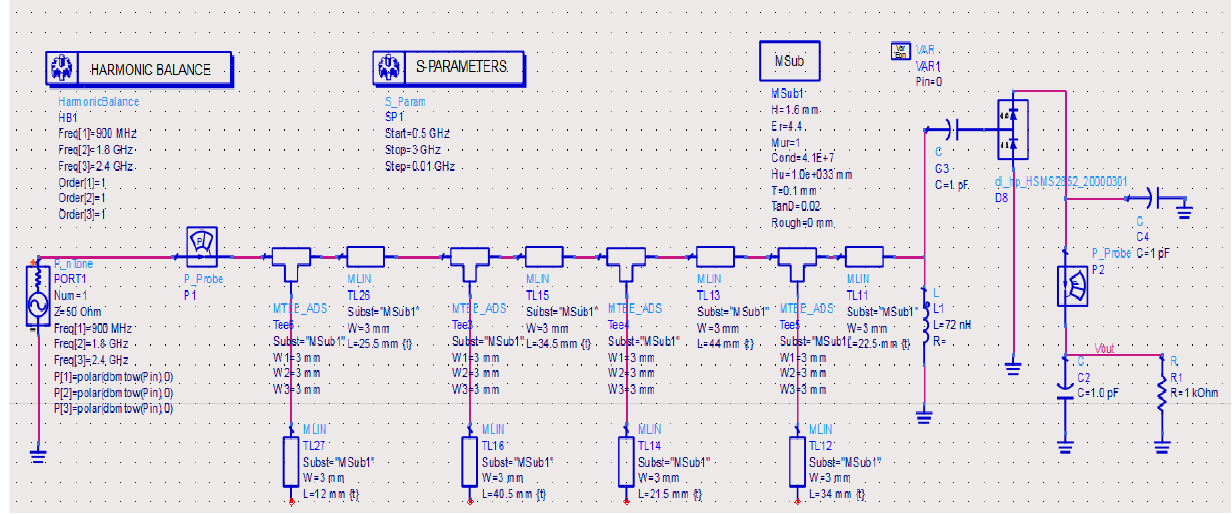
Figure 7: Rectifier circuit schematic with matching network.